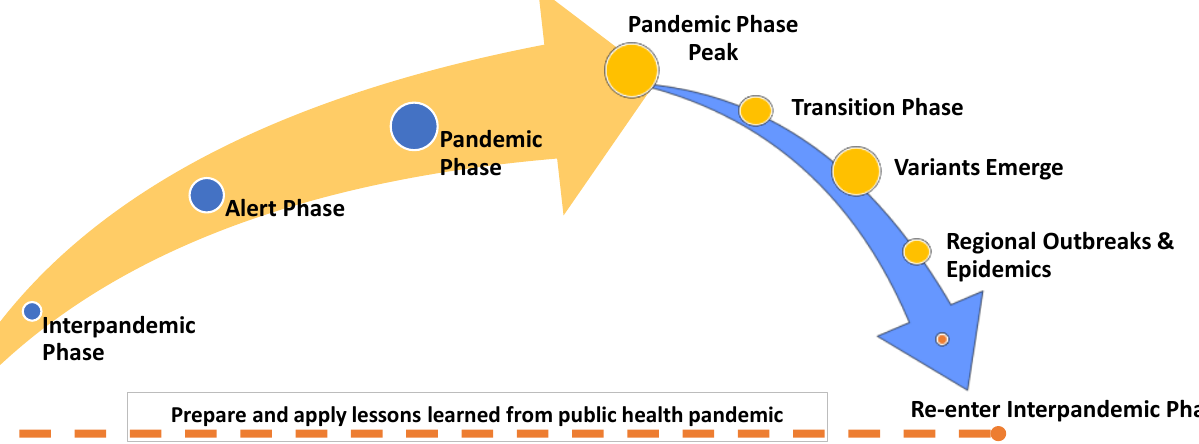
Figure 1. Conceptual framework for emergency risk management during pandemic response [14,15,17 – 22].